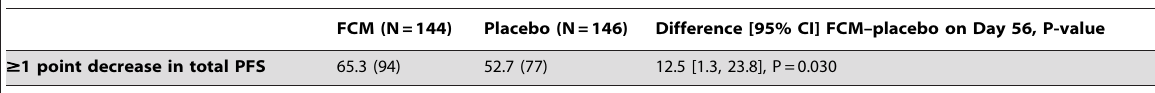
Table 2. Primary endpoint – Fatigue (% [n]) (ITT).